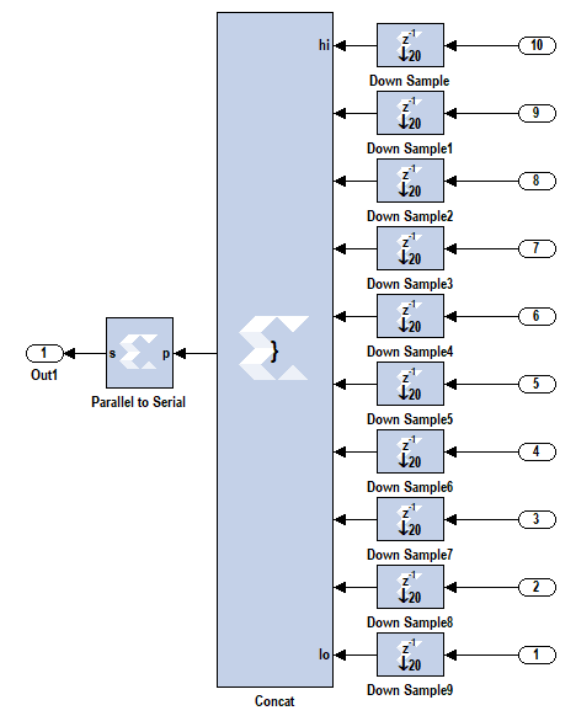
Fig. 17. The Xilinx SG block diagram of Down Sample